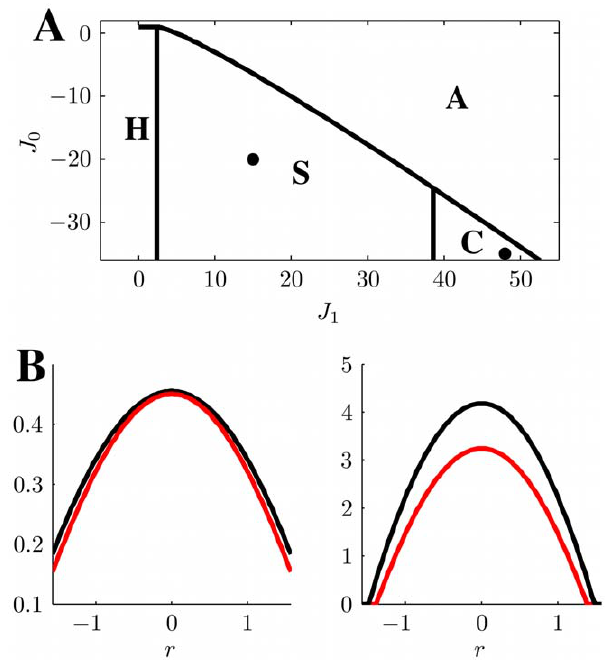
Figure 7. Comparison between whole morph sequence storage 1 . A: Phase diagram of the and two correlated maps with m ~ 2 model storing two correlated maps with m ~ 1 , in the plane J 1 , J 0 ð Þ . 2 Note that with this value of the distance, the double ring regime is not achievable. (A) region correspond to amplitude instability. B: Slice of the steady activity along r , in correspondence of the maximum in h . Left: parameters J 1 ~ 15, J 0 ~{ 20 ð Þ (dot in the S region). Right: J 1 ~ 48, J 0 ~{ 35 ð Þ ( C region); black curve, two stored maps; red curve, whole morph sequence stored. The bumps do not cover the whole